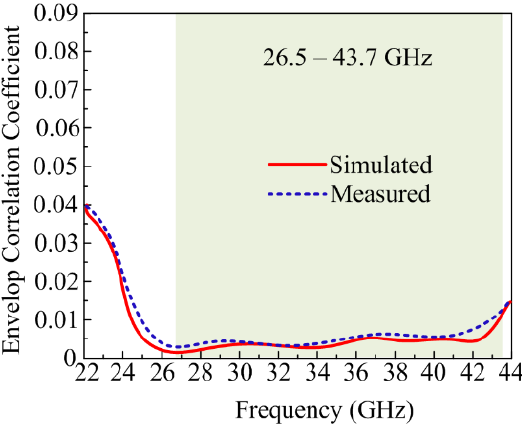
Figure 14. ECC of the proposed MIMO antenna.